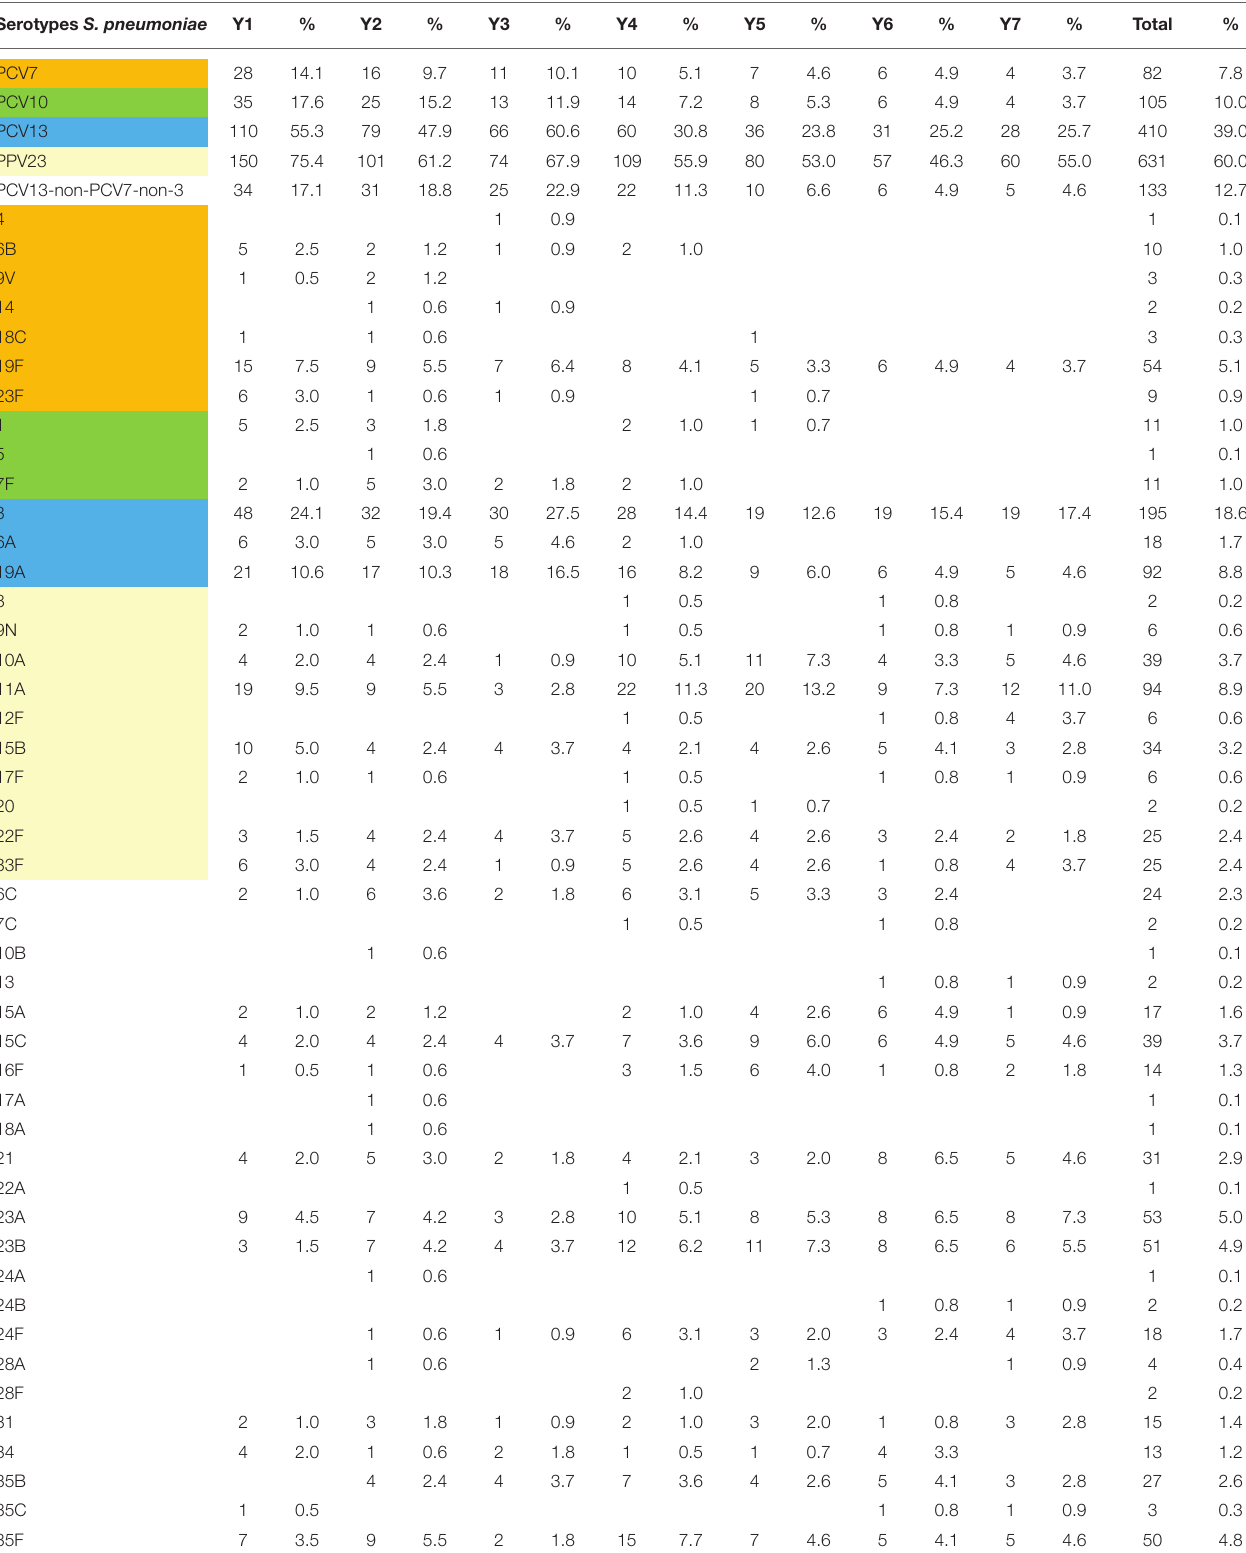
TABLE 5 | Prevalence of S. pneumoniae and H. influenzae serotypes and S. pyogenes emm types among NPS isolates over the seven study years. Serotypes S. pneumoniae